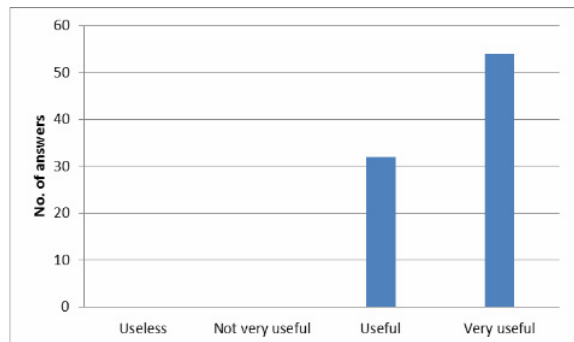
Figure 5. Results of Question 2